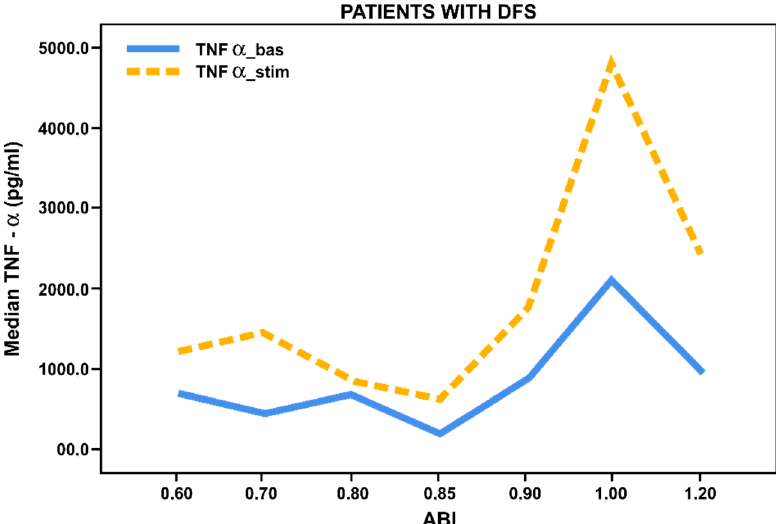
Figure 3. Basal and stimulated TNF- α secretion (pg/mL) by blood-derived monocytes from patients with long-term T2DM ( n = 42) with foot ulcers, depending on ABI (ankle-brachial index). Lines reflect median values.